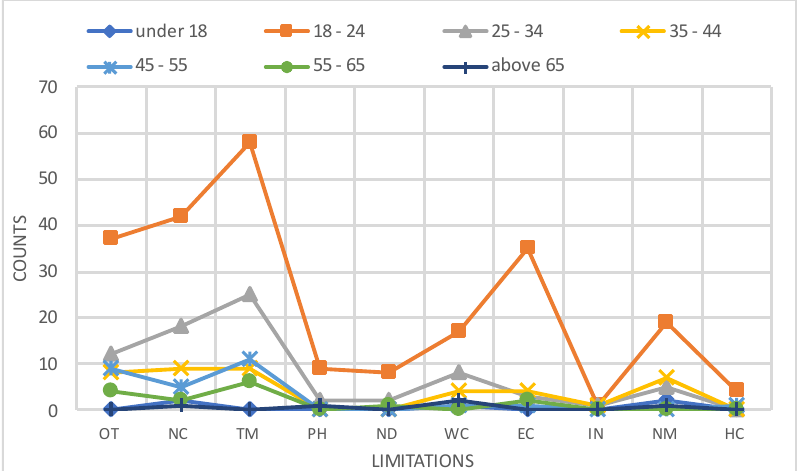
Figure 29. A graph of the interaction between limitations in the availability of tram transport and the age of the respondent.